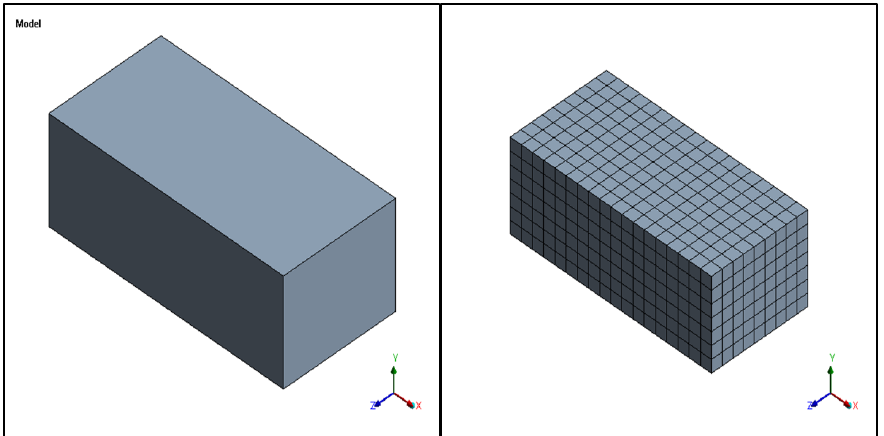
Figure 27. Model specimen of sustainable red mud bricks using ANSYS–Horizontal axis (HA).